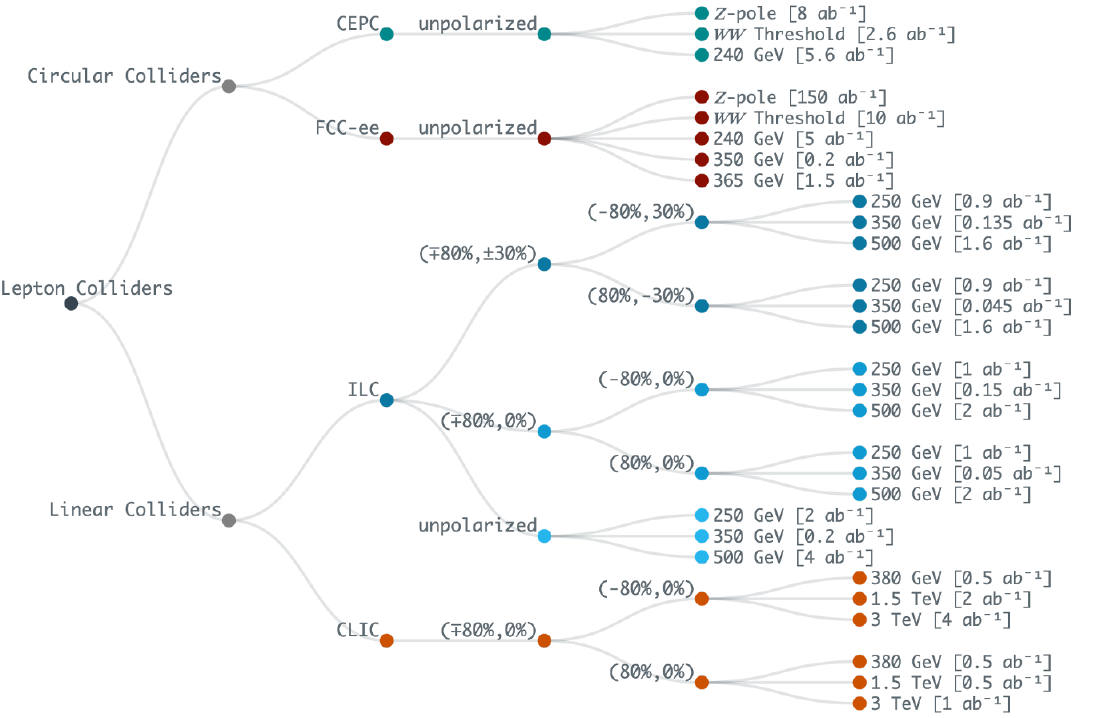
Figure 1 . A summary of run scenarios for CEPC, FCC-ee, ILC and CLIC considered in our analy- sis, with the corresponding integrated luminosities. The impact of beam polarization at the ILC is examined by considering P ( e (cid:0) ; e + ) = ( (cid:7) 80% ; (cid:6) 30%), ( (cid:6) 80% ; 0%) and unpolarized